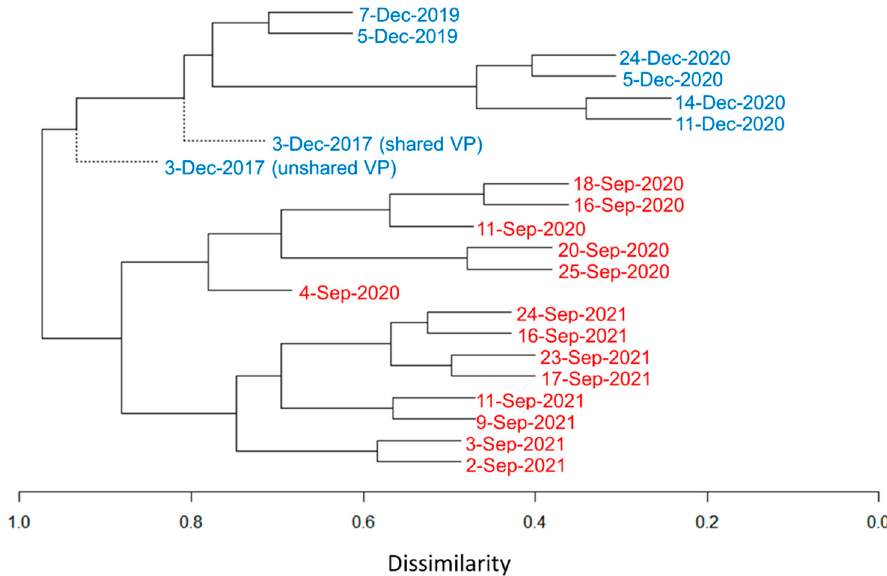
Figure 4. Bird community similarity in September (Sep, red) and December (Dec, blue) before restoration work (dashed lines) and after restoration (solid lines) at Al Karaana Lagoons in Qatar. Note that the period after restoration includes two years. Abundance data for each observed species were used.